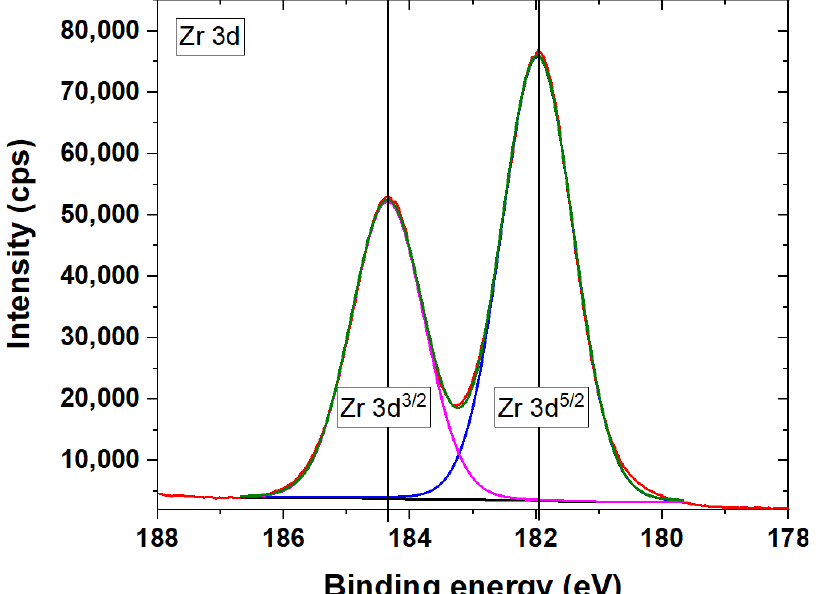
Figure 4. XPS spectra of the Zr 3d obtained on the Zr10-700. The colored lines represent components of spectral deconvolution (Voigt profiles) were each maximum corresponds to Zr 3d doublets. As it can be seen, the Zr 3d doublets Zr 3d 5/2 and Zr 3d 3/2 have a splitting energy of 2.4 eV and an area ratio of 3/2. The binding energy clearly indicates that Zr is in